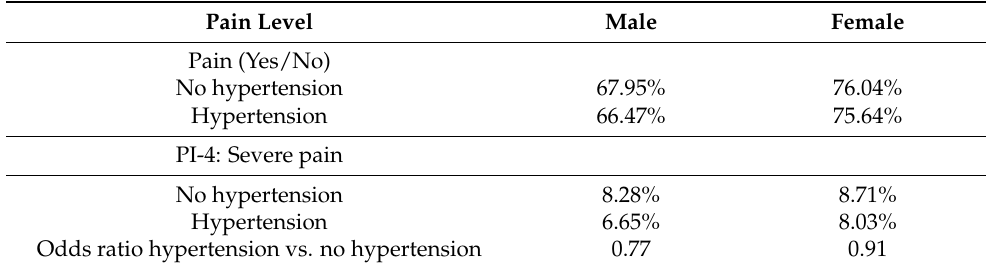
Table 6. Percentages of male and female residents with and without hypertension reporting pain on the four-level pain scale